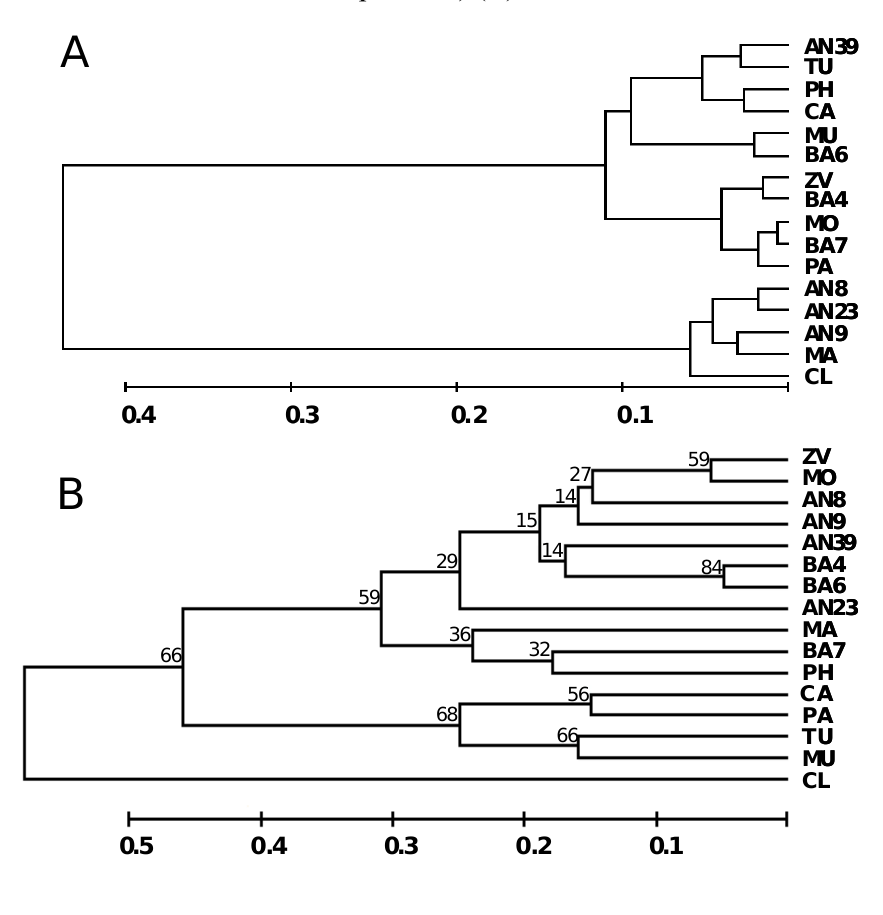
Figure 2. UPGMA dendrograms based on Gower [25] matrix following 13 morphological descriptors (A) and Nei et al. [29] matrix following ISSR analysis (50 polymorphic bands; numbers at the nodes indicate bootstrap values) (B) of 16 bean